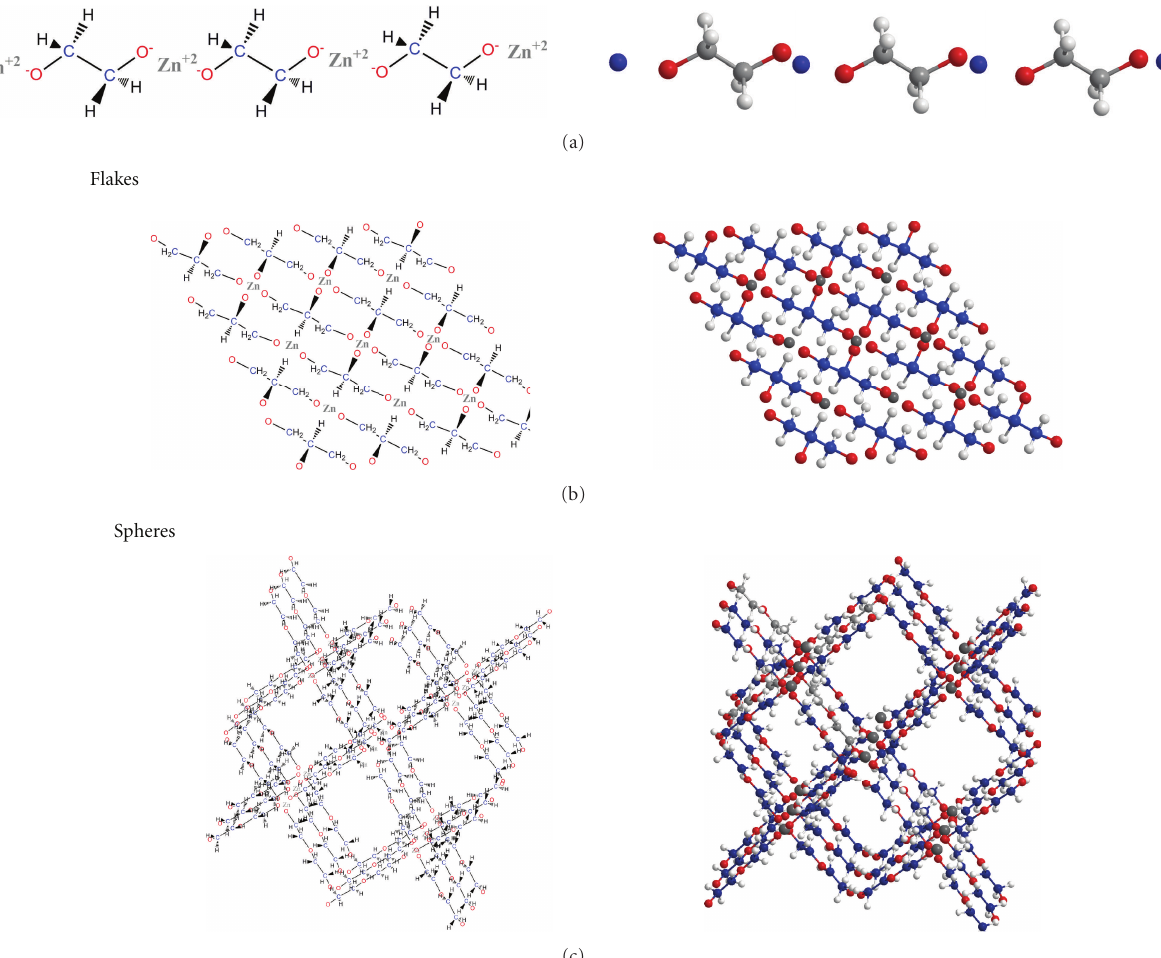
Figure 7: Formation mechanisms of ZnO fibers (1D), ZnO flakes (2D), and ZnO spheres (3D). Color code: blue: carbon, white: hydrogen, red: oxygen, and grey: